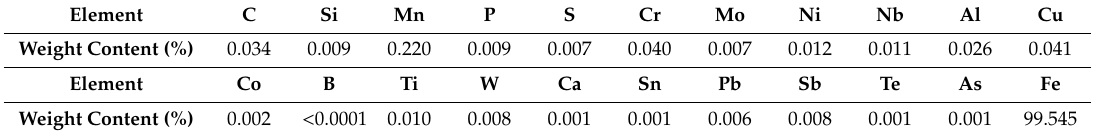
Table 1. Qualitative composition of steel subject to the phosphating